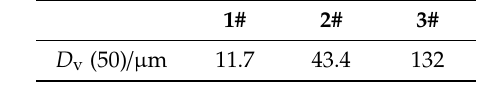
Table 2. The characteristic particle size for coal samples used in this